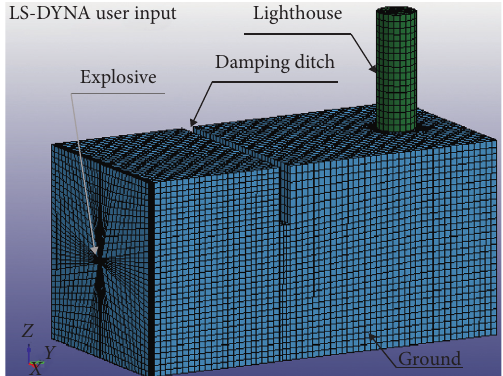
Figure 3: Mesh of the